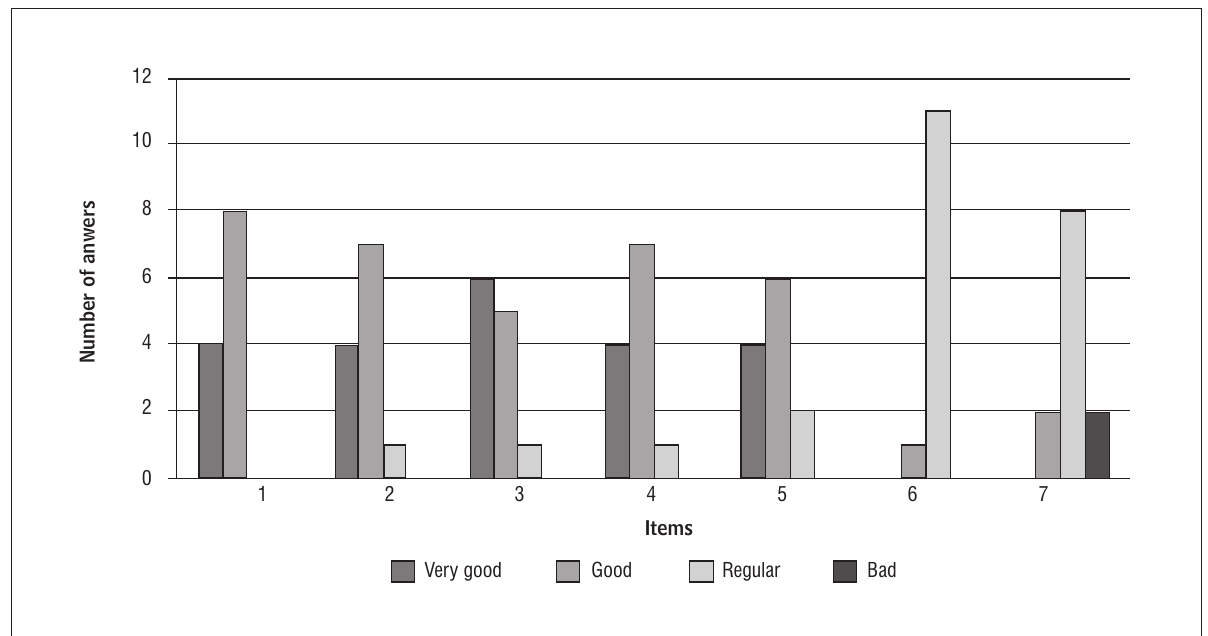
Figure 2 - Number of answers about the items on the questionnaire for the assessment of protocol to support the observation of stand-to-sit activity in